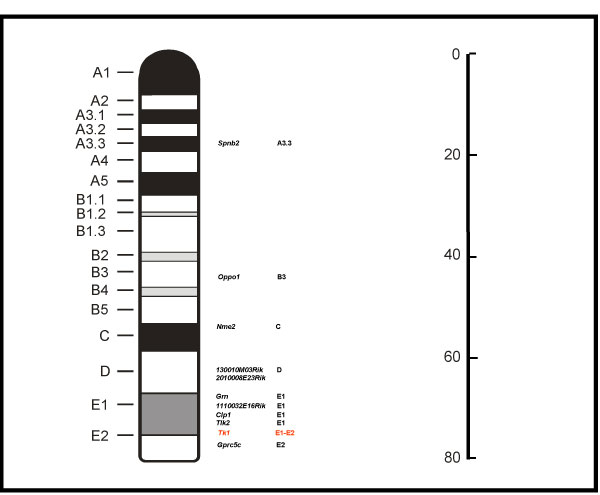
Map for chromosome 11 genes whose expression was significantly altered. The position of Tk1 gene in red is also shown for comparison. The right ruler indicates distance in cM (centimorgan) from top of the chromosome.